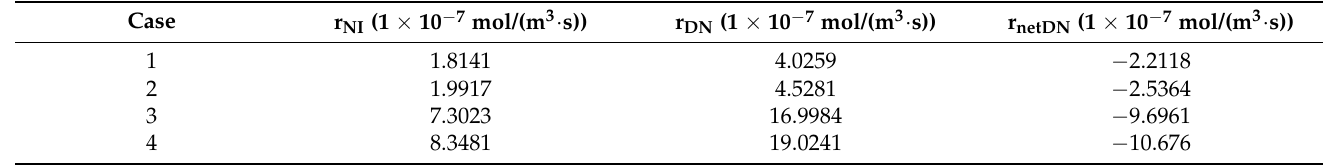
Figure 13. Distributions of reaction rates of net denitrification for different permeability coefficients. Table 6. Mean spatial reaction rates of nitrification, denitrification, and net denitrification.